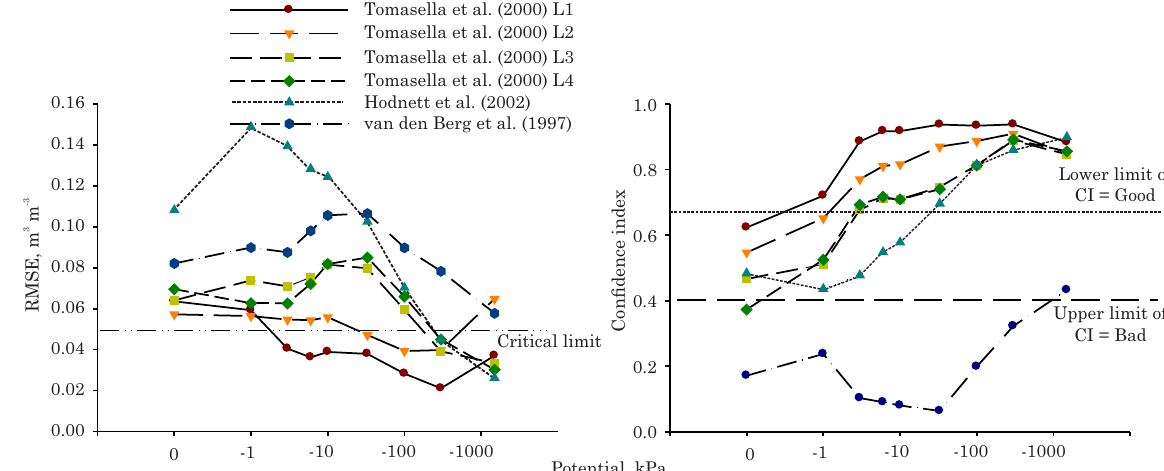
Figure 4. Values of RMSE and confidence index (CI) for the parametric PTFs tested for the surface soil layer (0-5 cm). CI > 0.85 = optimum; CI from 0.85 to 0.76 = very good; CI from 0.75 to 0.66 = good; CI from 0.65 to 0.61 = average; CI from 0.60 to 0.51 = tolerable; CI from 0.50 to 0.41 = bad; CI 0.40 = very